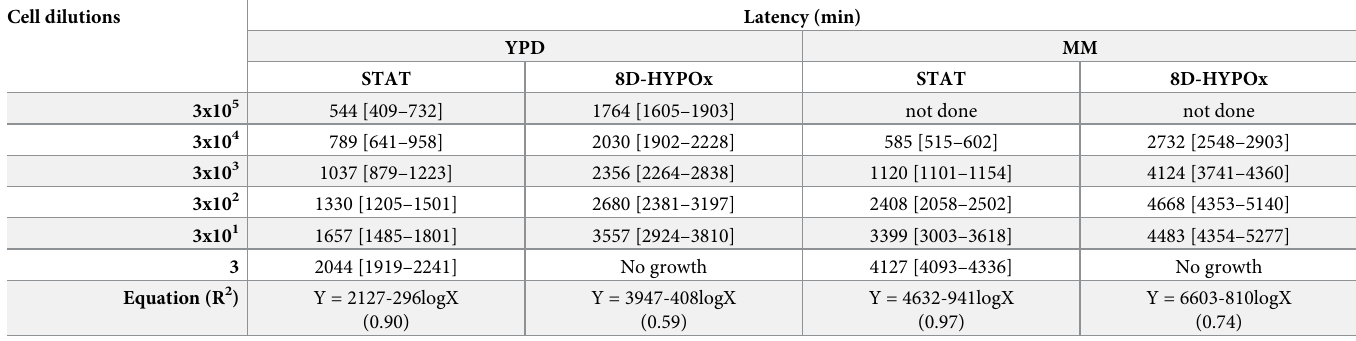
Table 1. Influence of cell dilutions and culture medium on the latency obtain from the growth curves. Cell dilutions